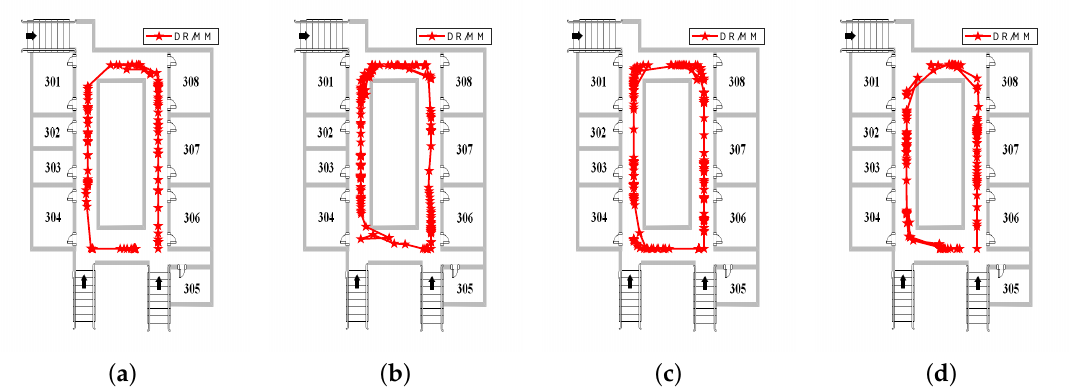
Figure 6. Positioning results for DR/MM in teaching building: ( a ) calling; ( b ) dangling; ( c ) handheld; and ( d )